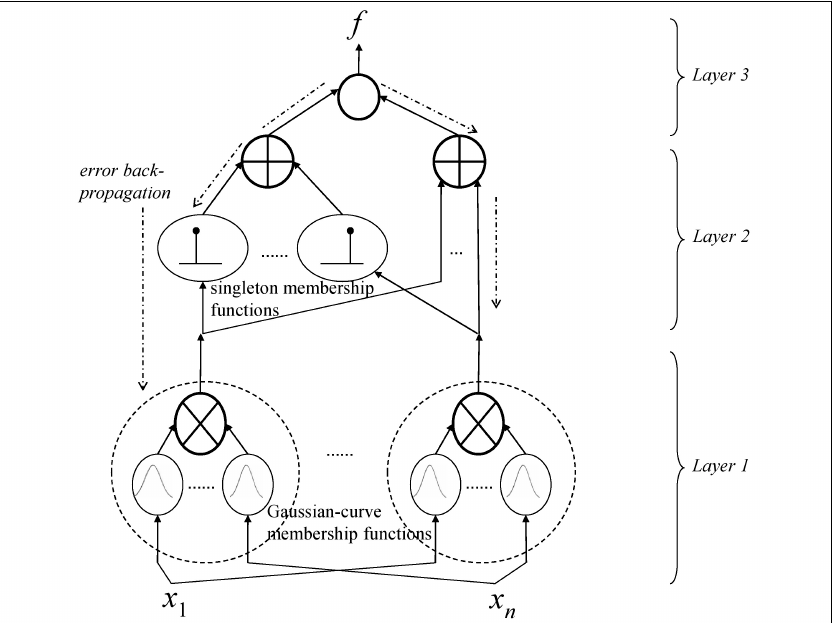
Figure 3. A feed-forward Artificial Neural Network (ANN)-architecture NFC.